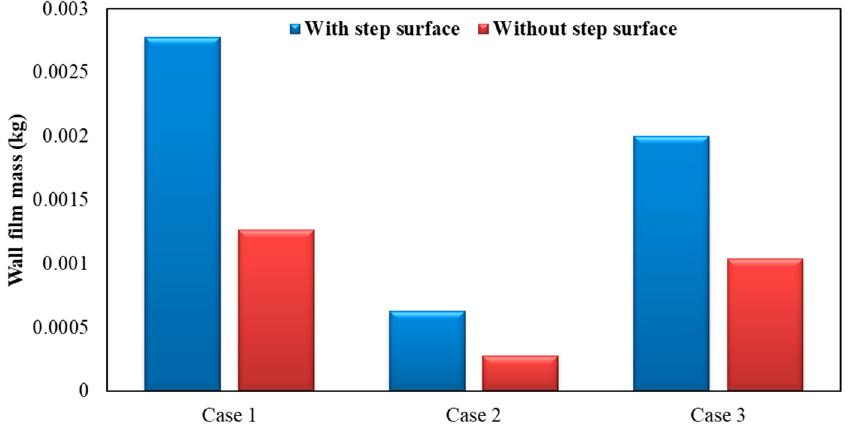
Figure 14. In fl uence of exhaust pipe with or without step surface on wall fi lm mass.